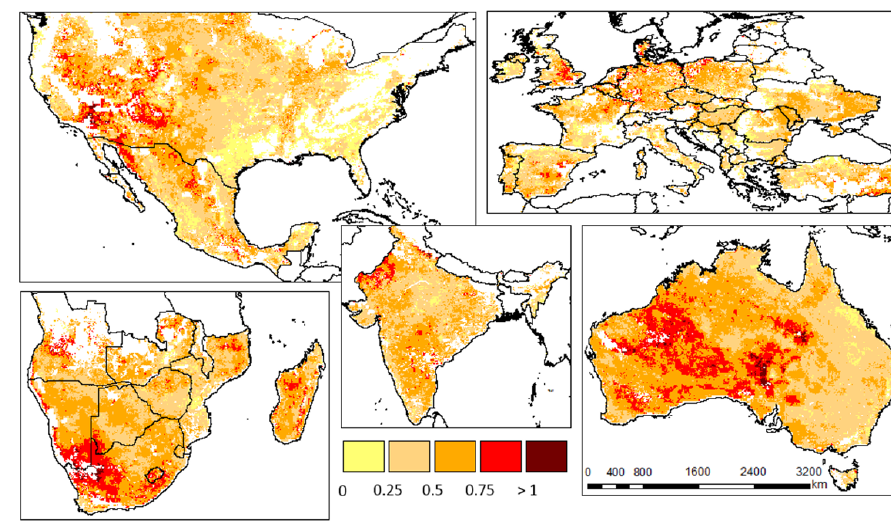
Figure 5. Spatial distribution of the error variance for the Lisflood (LIS) dataset over the five selected macro-regions.